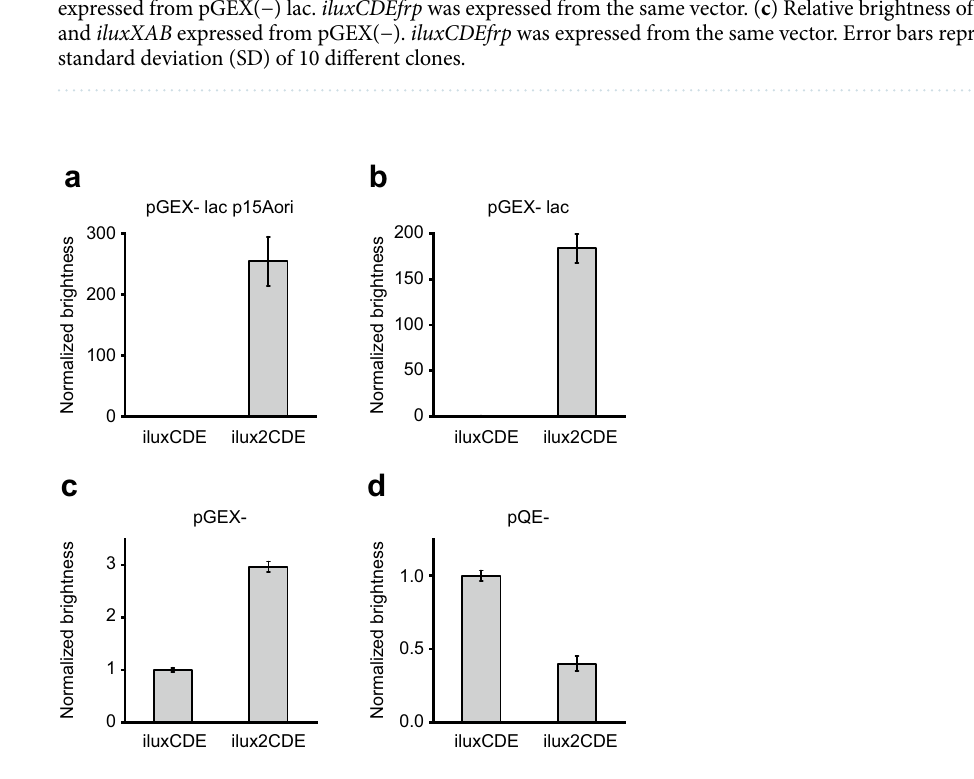
Figure 4. Mutagenesis and screening of iluxCDE . Plots show the relative bioluminescence signal normalized to iluxCDE . ( a ) For mutagenesis of iluxCDE , iluxCDE was expressed at low levels from the vector pGEX(−) lac p15Aori whereas iluxABfrp was simultaneously expressed at high levels from pGEX(−) Kan. Repeated rounds of mutagenesis resulted in the brighter variant ilux2CDE . ( b ) Relative brightness of iluxCDE and ilux2CDE expressed from pGEX(−) lac. iluxABfrp was expressed from the same vector. ( c ) Relative brightness of iluxCDE and ilux2CDE expressed from pGEX(−). iluxABfrp was expressed from the same vector. ( d ) Relative brightness of iluxCDE and ilux2CDE expressed from pQE(−). iluxABfrp was expressed from the same vector. Error bars represent SD of 10 different